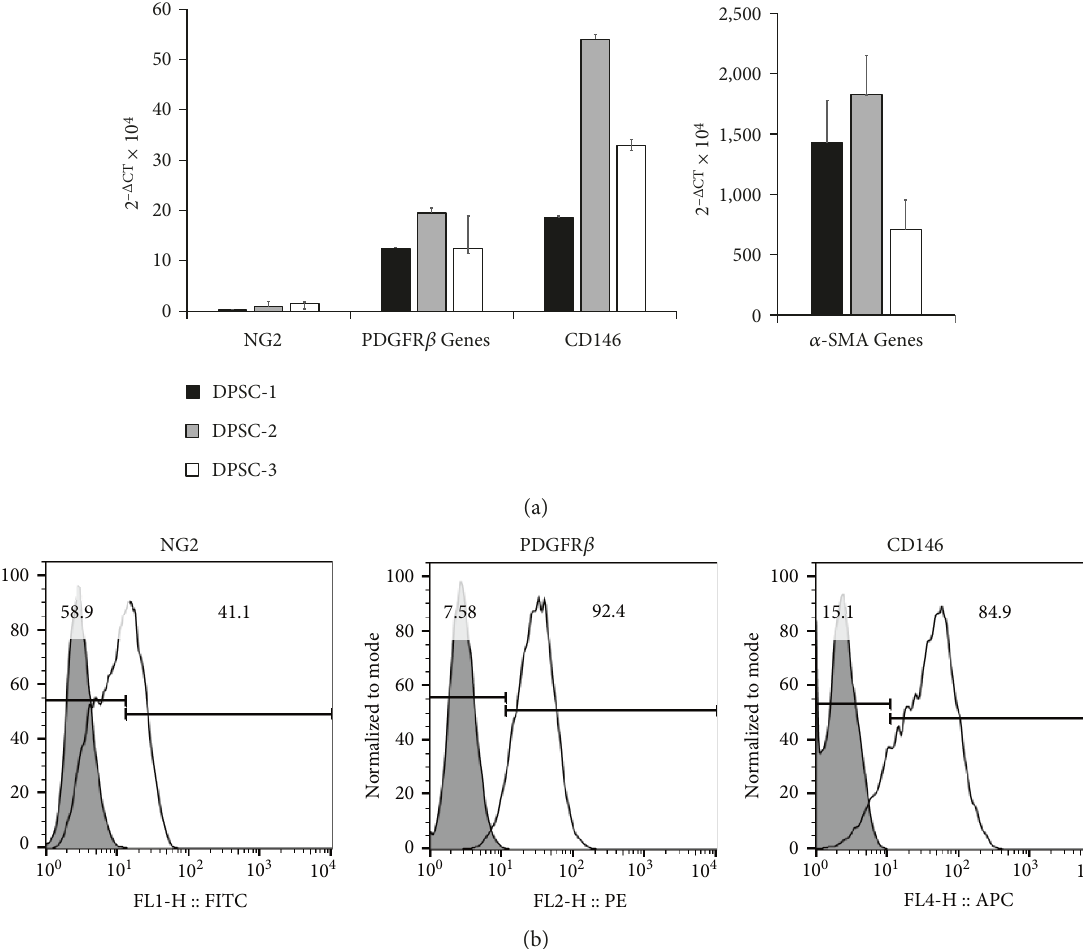
Figure 2: The expression of perivascular markers in DPSCs. The expression of perivascular markers in three di ff erent lines of DPSCs was determined by qPCR and FACS analysis. (a) DPSCs expressed NG2 , α -SMA , PDGFR β , and CD146 . Arbitrary unit in y -axis represented 2 −Δ CT × 10 4 . (b) In the results by FACS analysis, DPSCs expressed NG2, PDGFR β , and CD146. However, the expression of NG2 was subdivided into NG2-positive and NG2-negative populations dependent on the lines of DPSCs. The expression of CD146 was broadly distributed. One of representative pieces of data was